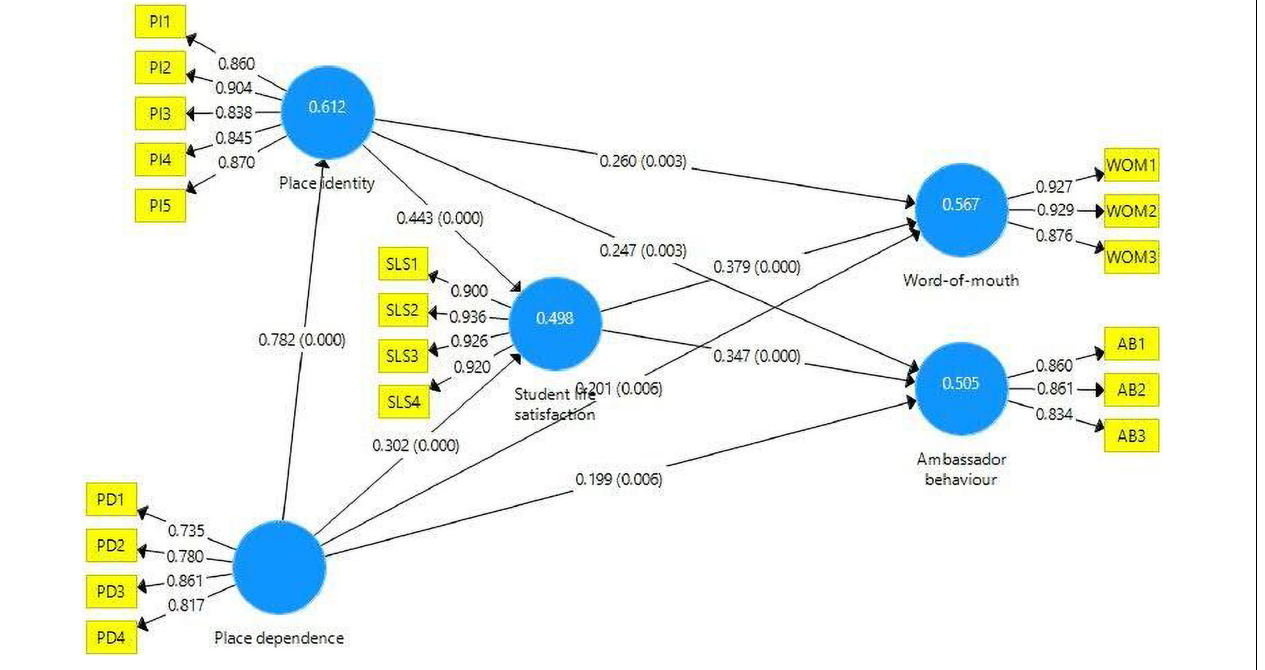
FIGURE 2 | Results of PLS-SEM